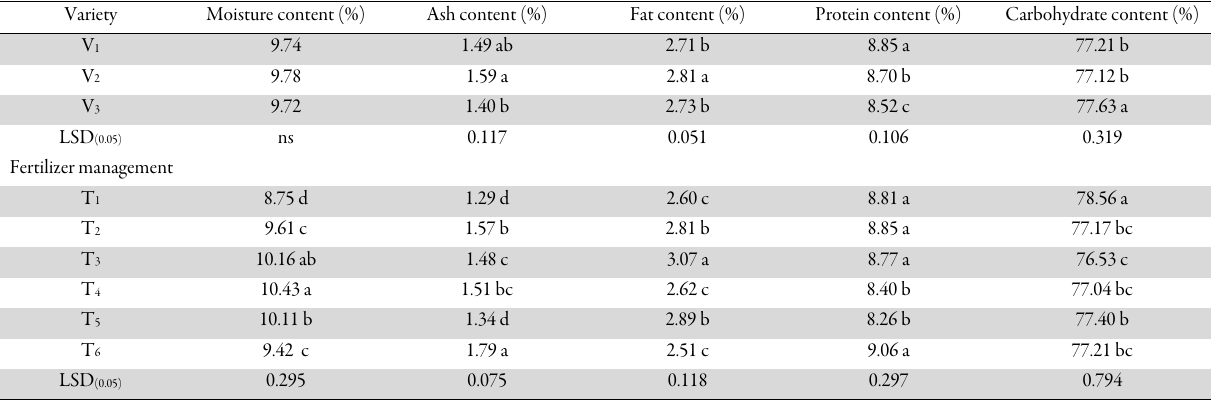
Table 5. Effect of varietal variation and fertilizer management on proximate composition of rice Variety